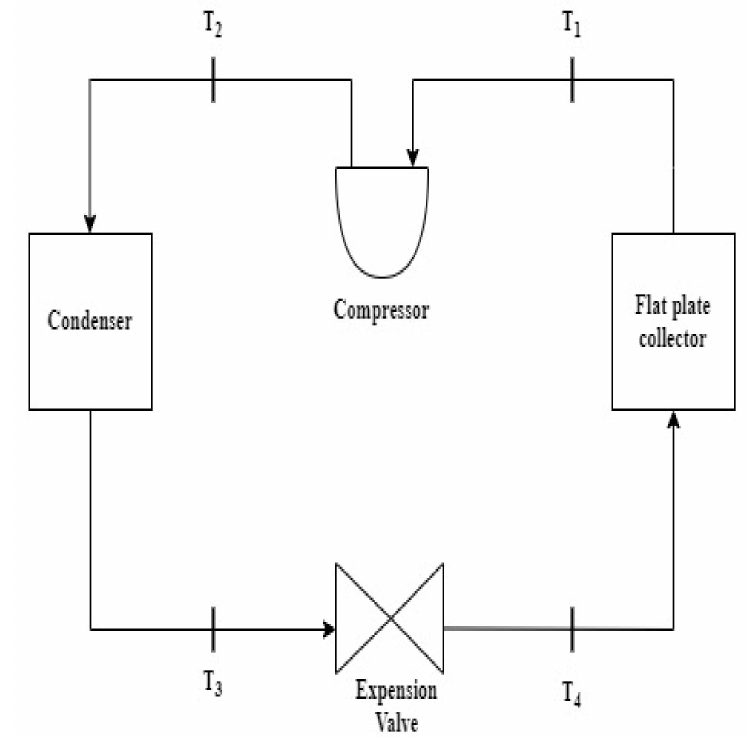
Figure 9. Line diagram of solar- assisted heat